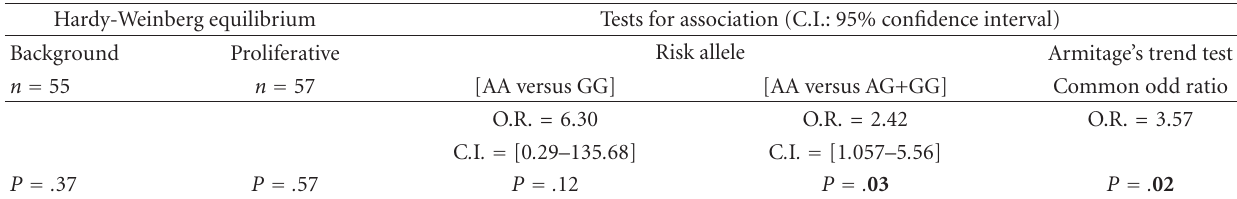
Table 5: Hardy-Weinberg equilibrium and association tests for A-2819G and proliferative retinopathy. Hardy-Weinberg